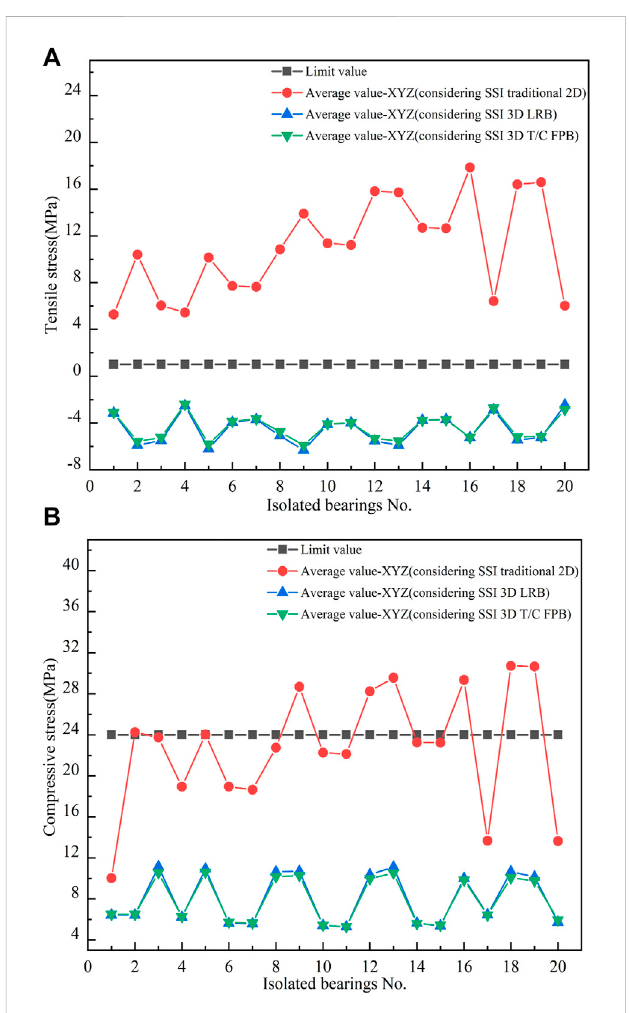
FIGURE 8 Stressofisolatedbearings. (A) Tensilestressofisolatedbearings. (B) Compressive stress of isolated bearings.